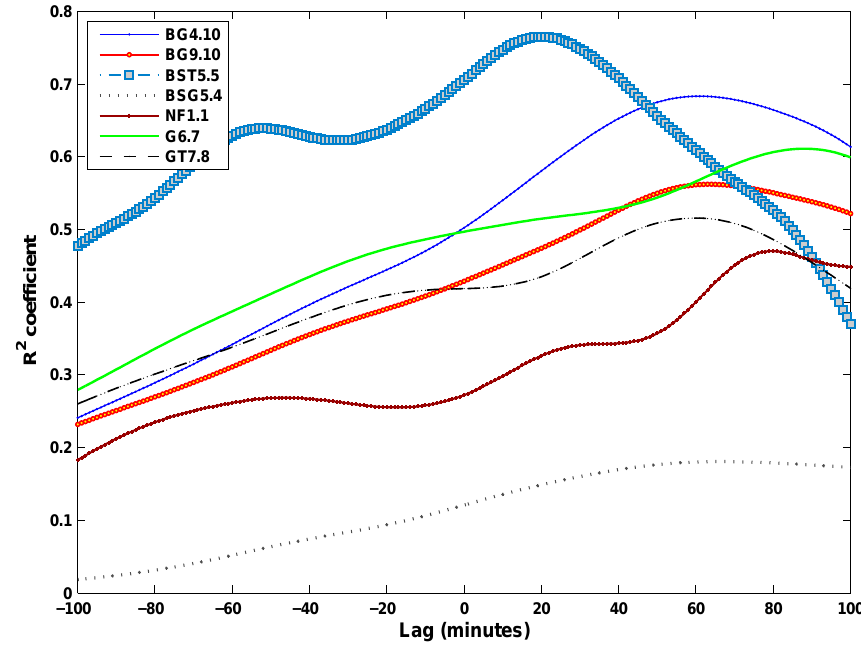
Figure 11. Variations of regression R 2 statistics from correlations between iButton GST measurements over 5 LC types and time-series of the corresponding MODIS LST